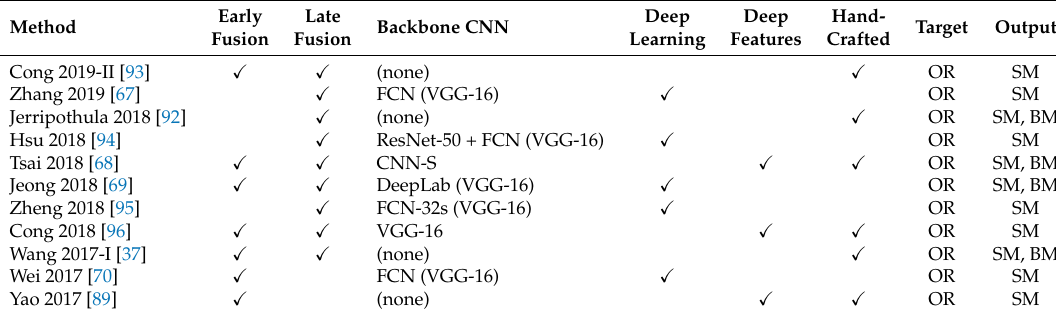
Table 5. Characteristics of the analyzed methods for co-saliency estimation. The “Target” column indicates the nature of the ground truth used to train or develop the methods, while “Output” describes what data they are explicitly able to generate (OR = Object Regions, SM = Sharp saliency Maps, BM = Binary